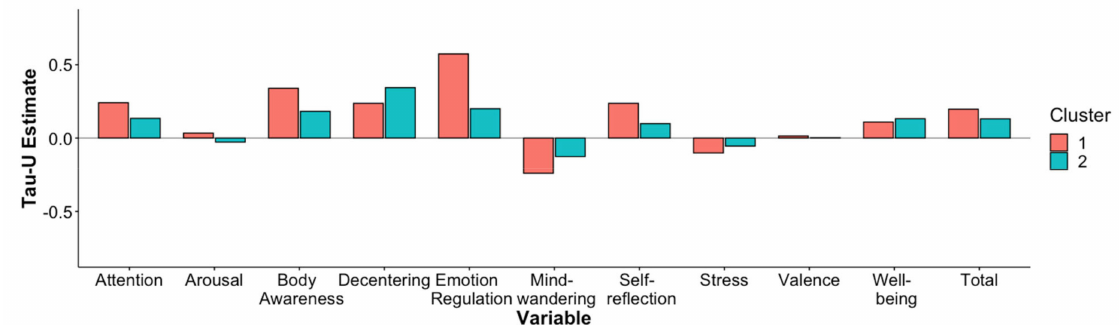
Figure 2. Comparative bar chart displaying the mean of the dependent variables for both